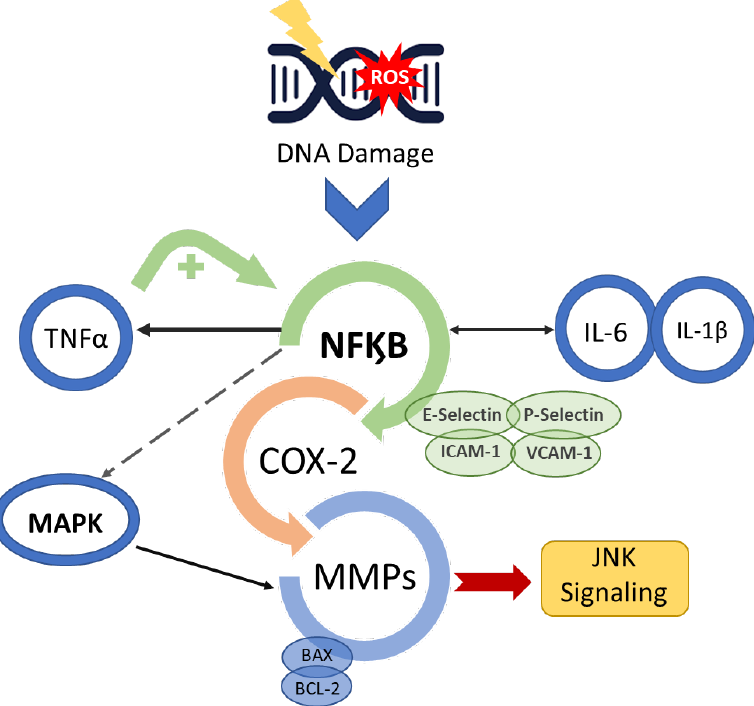
Figure 2. Mucositis signal amplification. Anti-cancer treatment activates the transcription